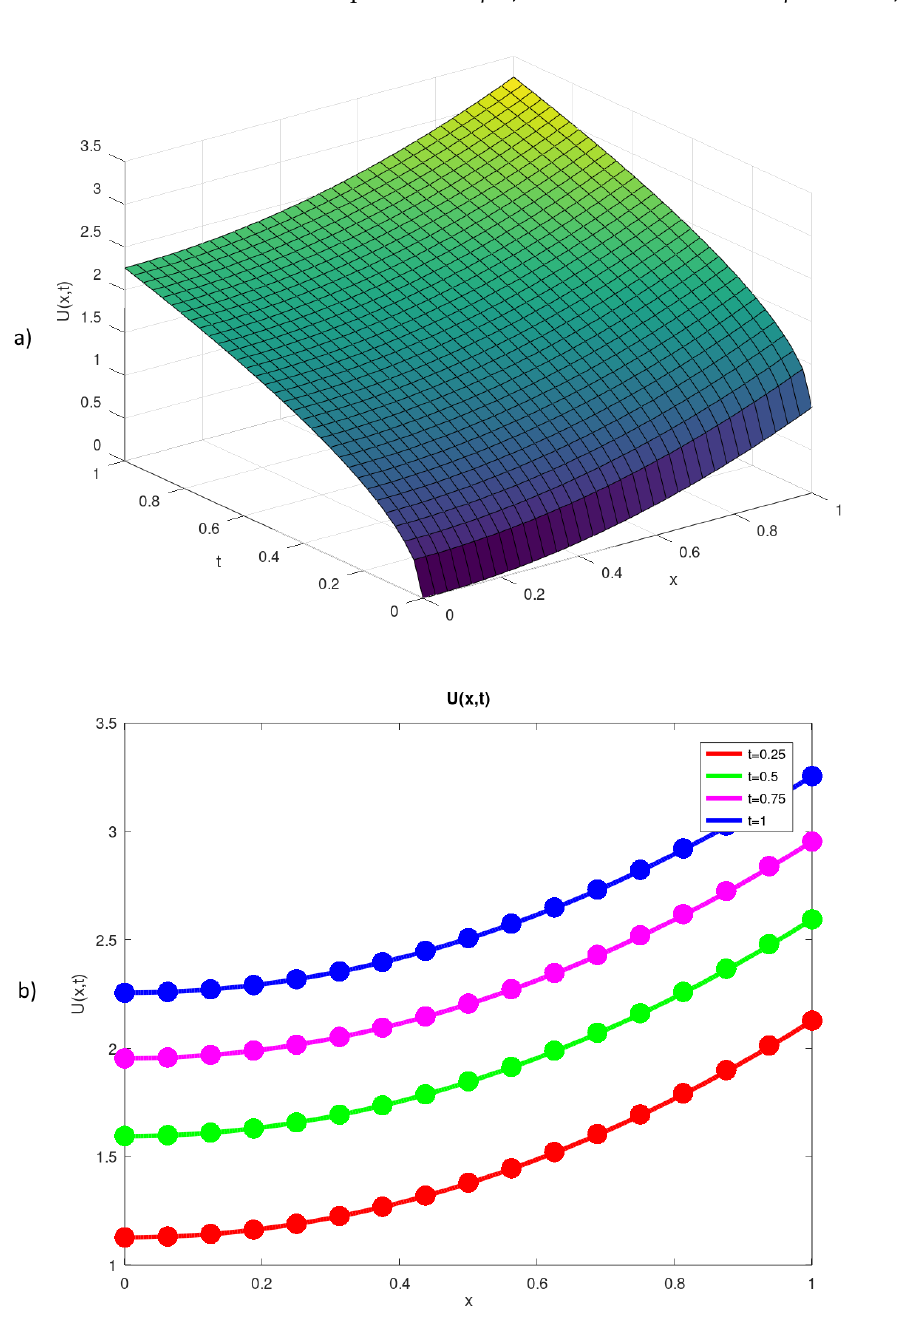
Figure 1. ( a ) Approximate solution (cid:101) U ( x , t ) of Problem 1 obtained by the Thomas algorithm; ( b ) exact (solid line) and approximate (dots) solutions at several time